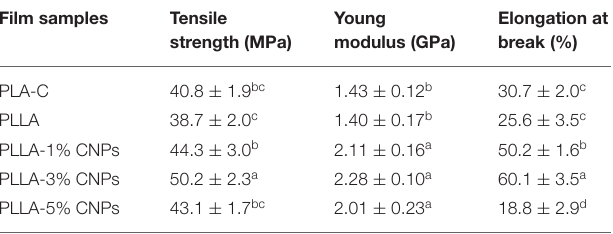
TABLE 5 | Mechanical properties of poly (L-lactic acid) (PLLA) nanocomposite films, compared to neat PLA and PLLA films.